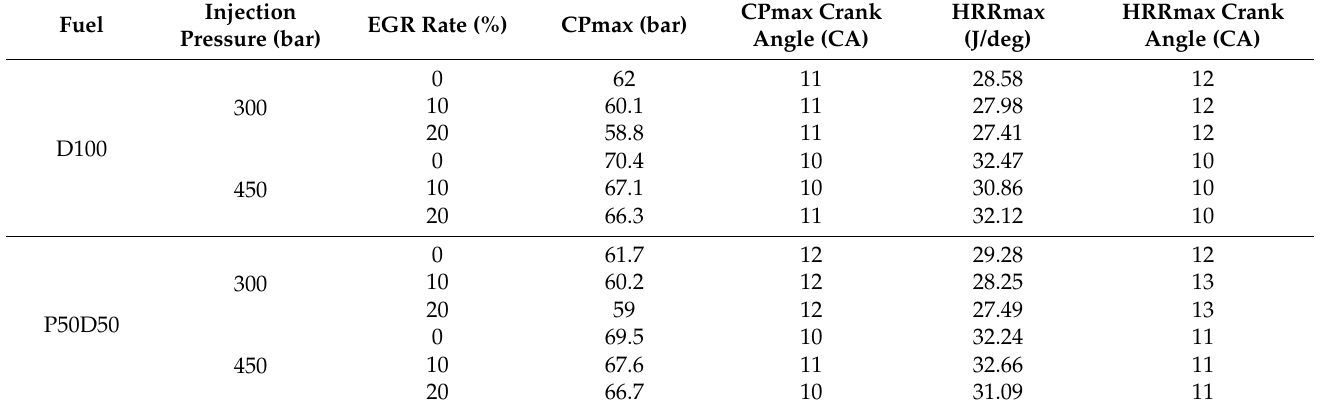
Table 6. Maximum values of CP and HRR and their corresponding crank angles (with